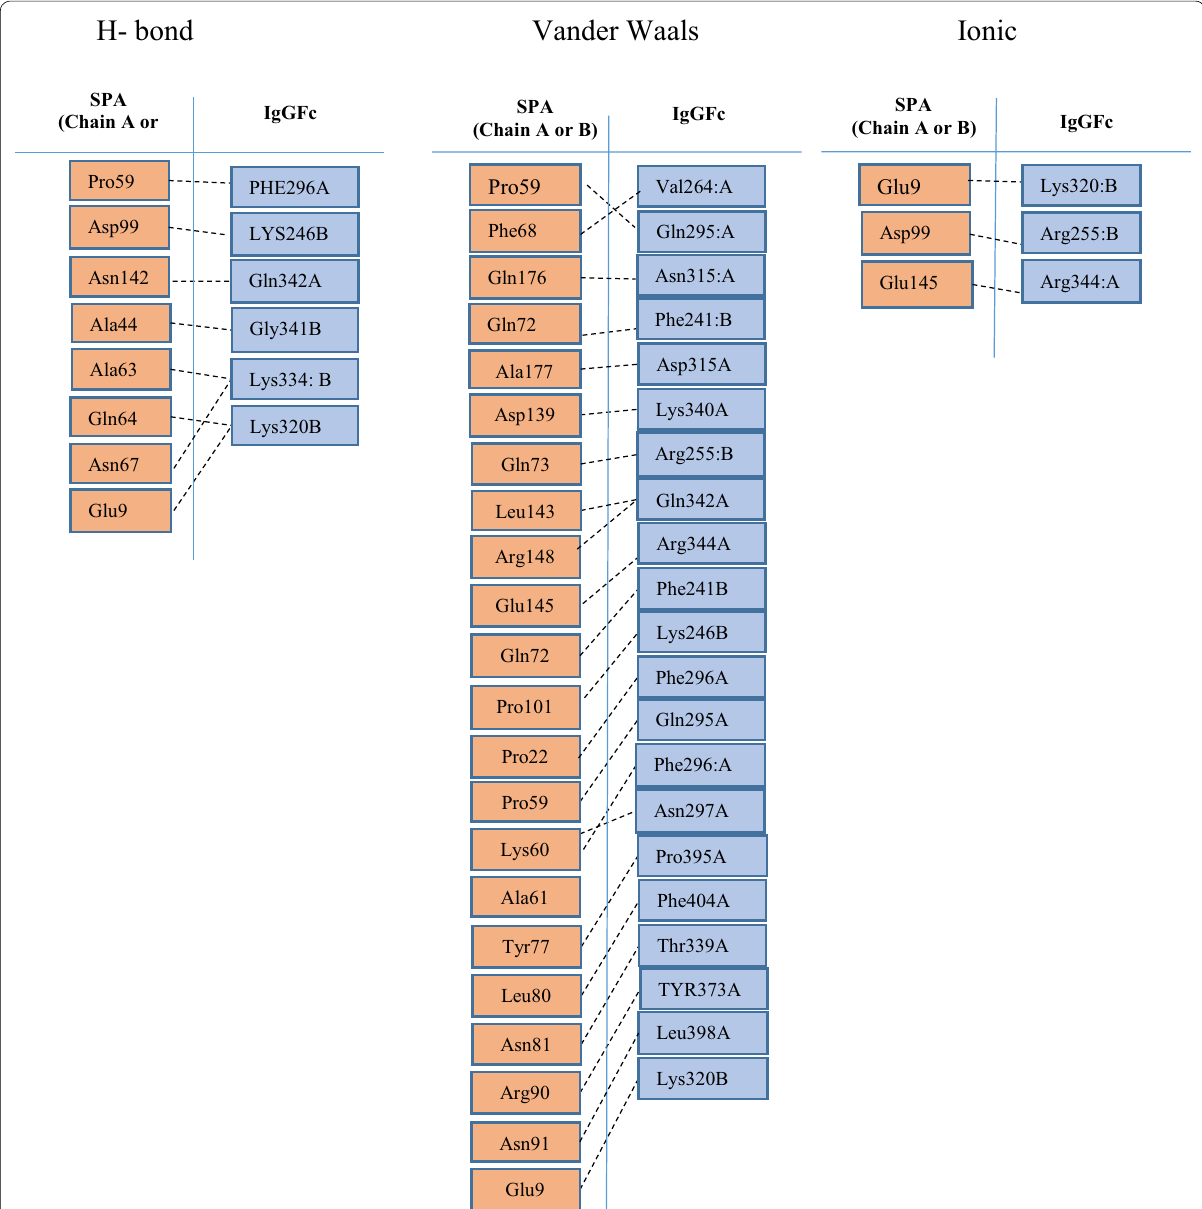
Fig. 3 Illustration of H-bonds, Vander Waals and ionic interaction of SpA 295 with IgG Fc observed after 30 ns molecular dynamic simulation (yellow broken lines represent H-bonds between two